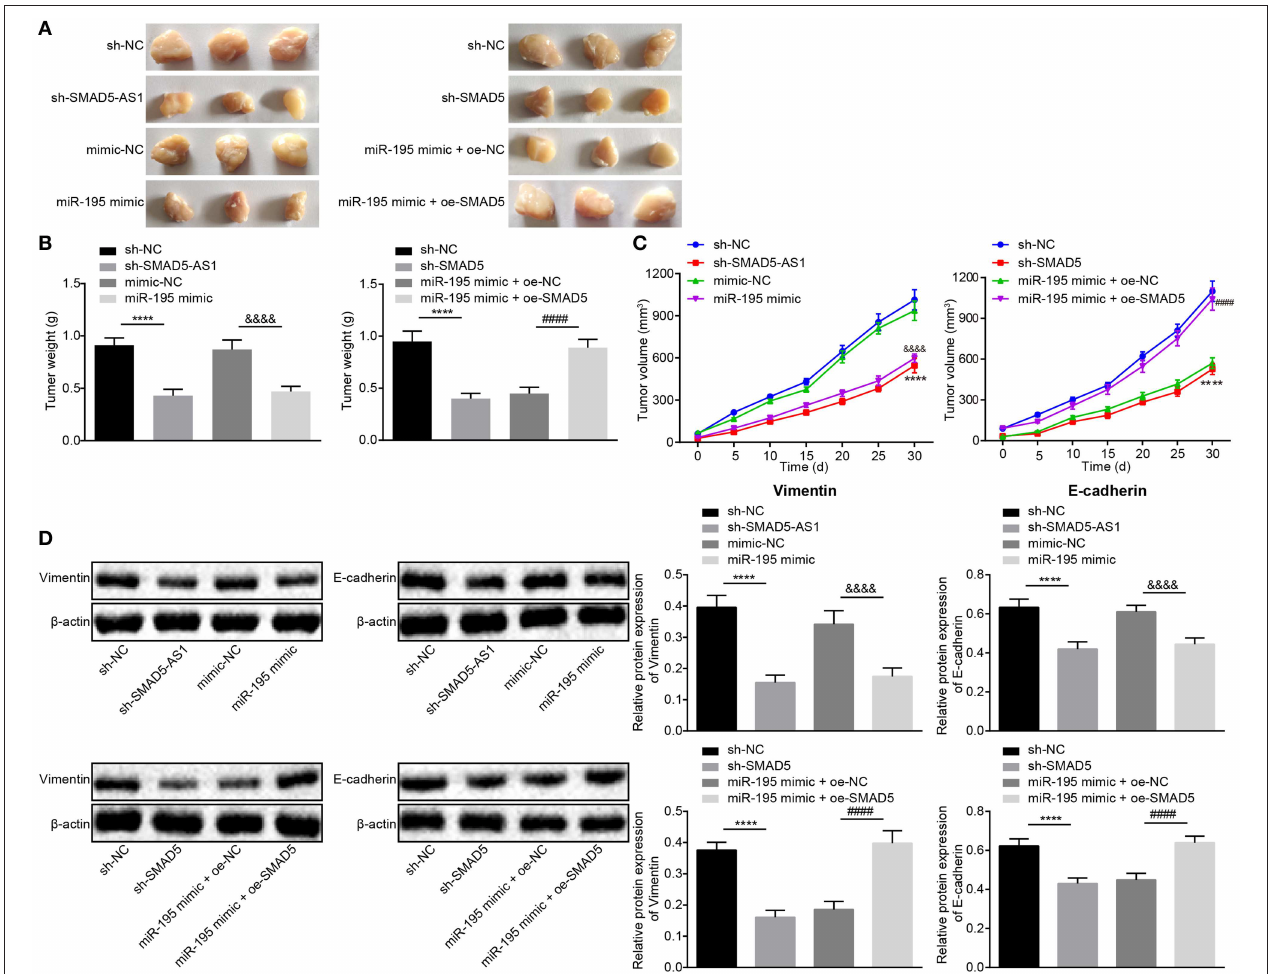
FIGURE 7 | The tumorigenesis and EMT were suppressed in response to depletion of SMAD5-AS1 or SMAD5 or elevation of miR-195 in vivo . (A–C) Xenograft tumors (A) and quantitative analysis of tumor weight (B) and volume (C) in mice injected with CNE-2 cells that had been infected with lentivirus carrying miR-195 mimic, sh-SMAD5-AS1, and sh-SMAD5. (D) Protein expression of EMT-related Vimentin and E-cadherin in mice injected with the infected CNE-2 cells detected by western blot analysis. **** p < 0.0001 vs. the sh-NC group; &&&& p < 0.0001 vs. the mimic-NC group; #### p < 0.0001 vs. the miR-195 mimic + oe-NC group. The measurement data were expressed as mean ± standard deviation. n = 6. Independent sample t -test was adopted to compare data between two groups, and repeated measures ANOVA was used to compare the two groups at different time points, followed by Bonferroni post-test. The experiment was repeated 3 times.